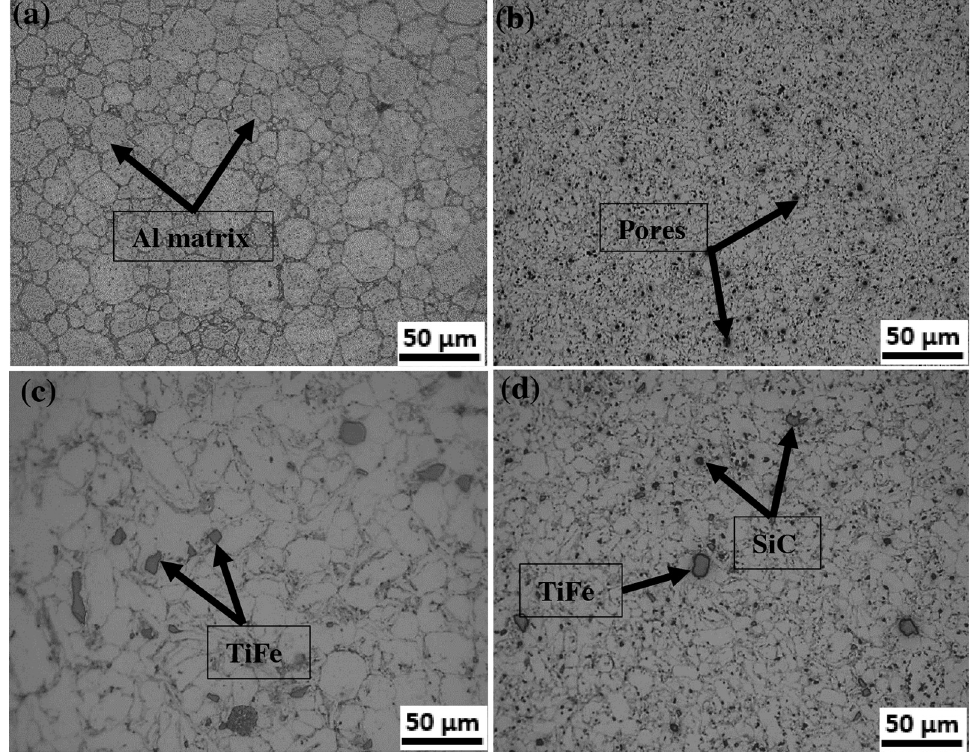
Fig. 1. Optical micrographs of (a) Pure aluminium (b) Al+ 2% SiC (c) Al + 2% TiFe (d) Al + 2% TiFe +2% SiC.